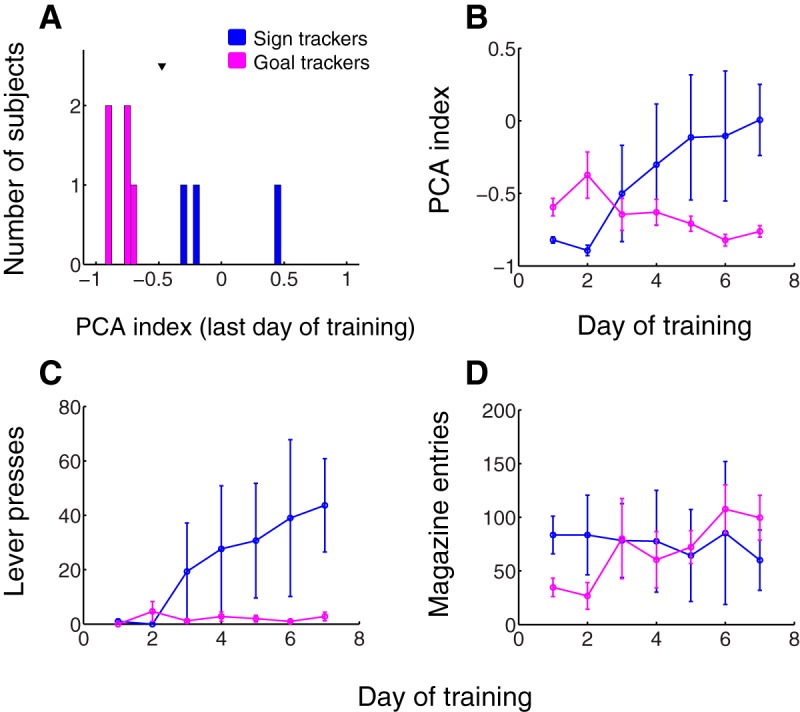

Sign tracker and goal tracker individuals differed mainly in their level of interaction with the lever cue. A, PCA index (see Materials and Methods) for all subjects measured during the last training session (day 7). Arrowhead, mean PCA index. Blue, subjects categorized as sign trackers; magenta, goal trackers. B–D, PCA index (B), total lever presses (C), and total magazine entries during the cue (D) over all 7 d of training for sign trackers (blue) and goal trackers (magenta). Error bars, SEM.